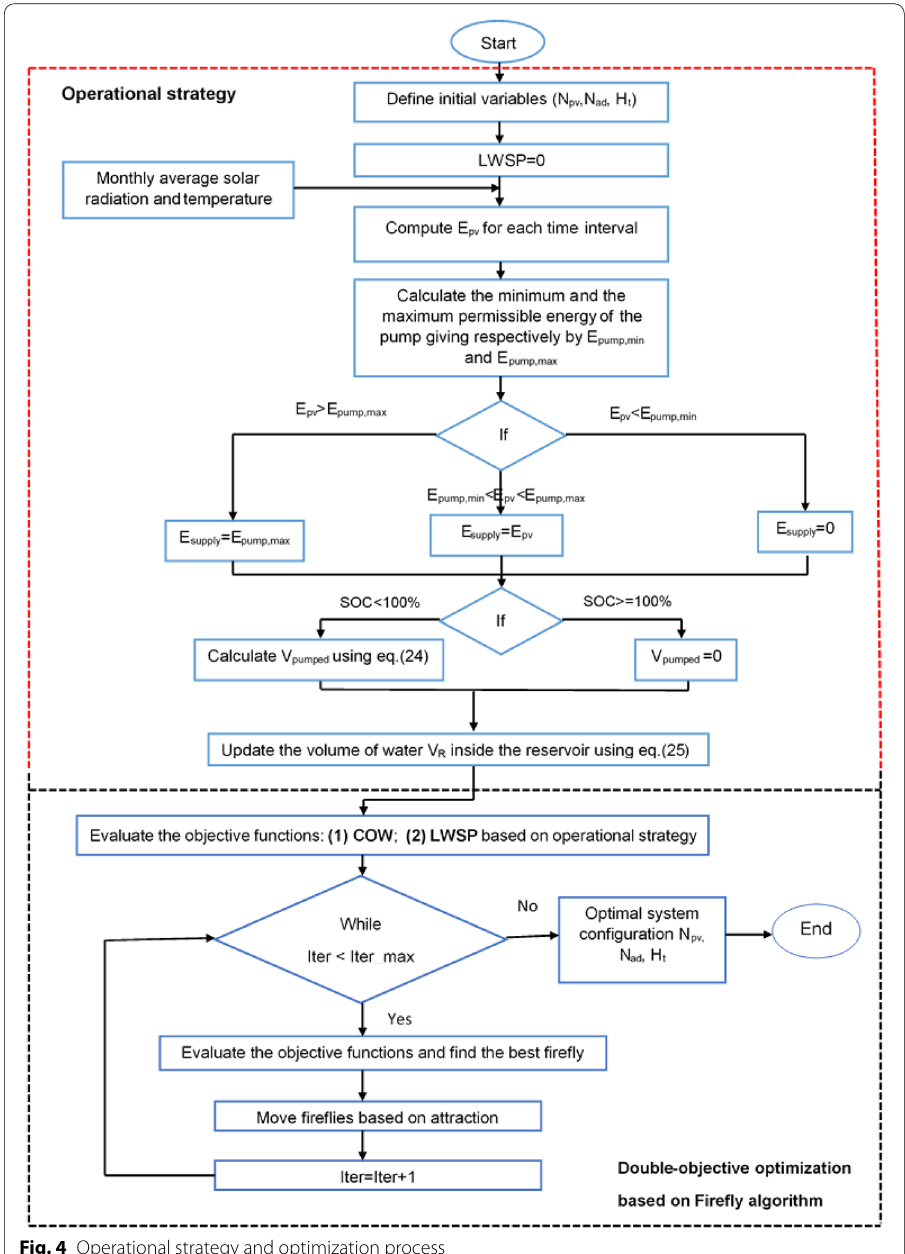
Fig. 4 Operational strategy and optimization